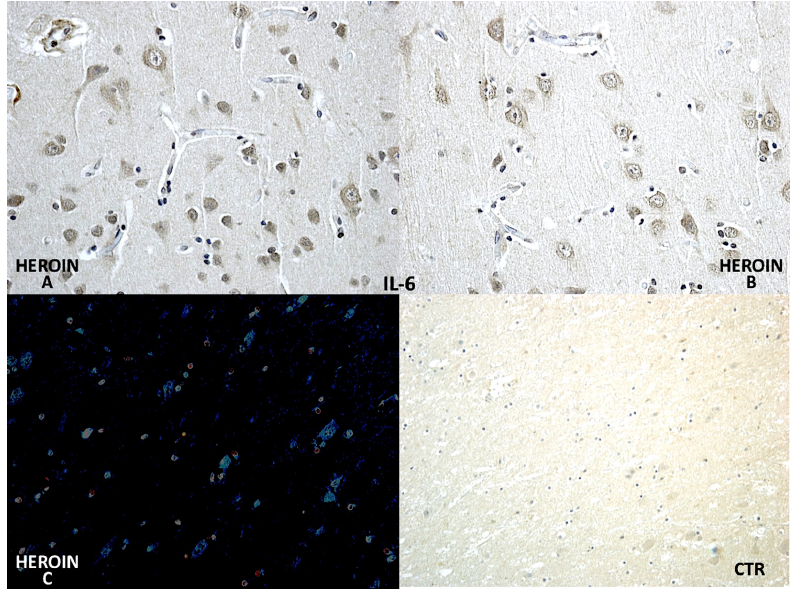
Figure 2. Differential immunohistochemical reaction of IL-6 in group of heroin-related death and control group showed a strong and diffusely neuronal and oligodendrocyte ( A , B ) positivity (in C confocal laser microscopy with neuronal reaction in cyan color). CTR negative control case.